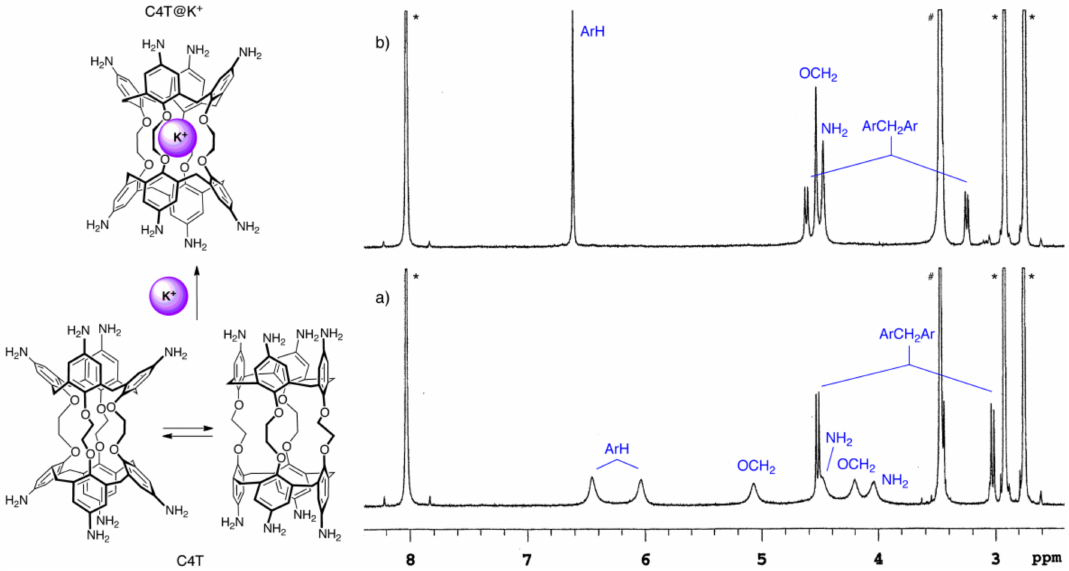
Figure 1. 1 H NMR (DMF- d 7 , 298 K) of: ( a ) octa-amino calix[4]tube C4T ; ( b ) the potassium complex of the octa-amino calix[4]tube C4T @K + . The hashtag and the asterisks indicate the H 2 O and the residual solvent peaks,